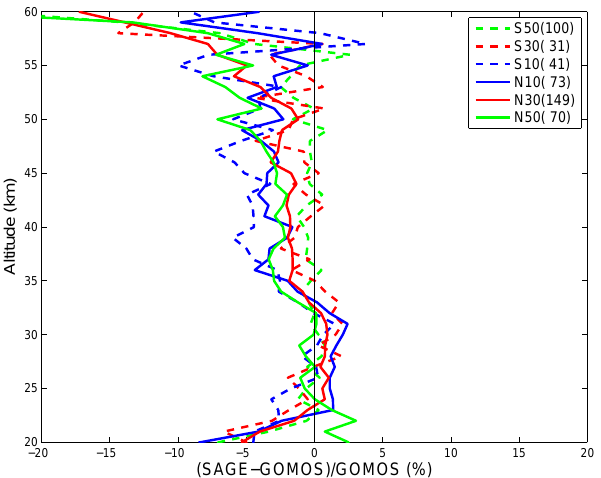
Fig. 8. The percent differences of SAGE II sunset and GOMOS nighttime measurements in 20 ◦ latitude bands. The line labels show the centers of the latitude bands and the number of collocations.